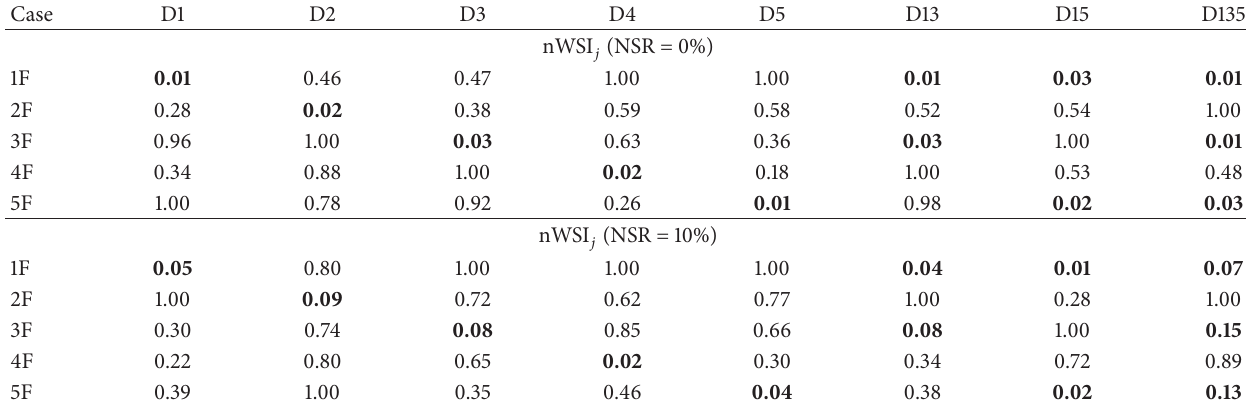
Table 2: Summary of damage assessment under various noise levels